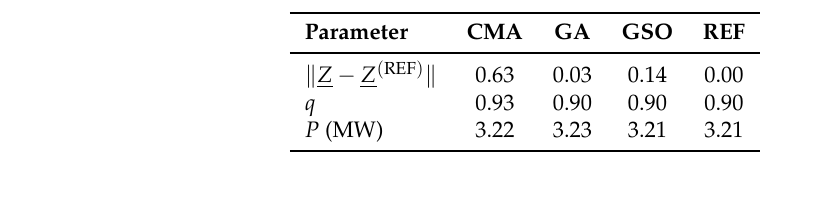
Table 2. Distances between best layout solutions in the parameter space, their q -factor and their yearly power production.